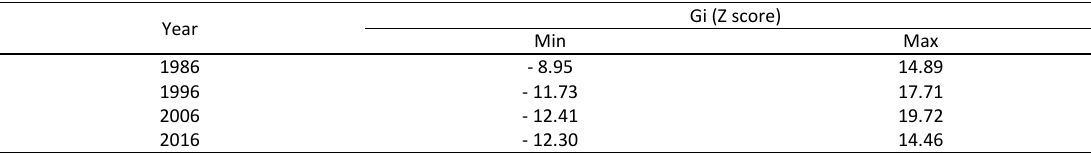
Table 5: The calculated values of Gi statistic for each census block of Mashhad